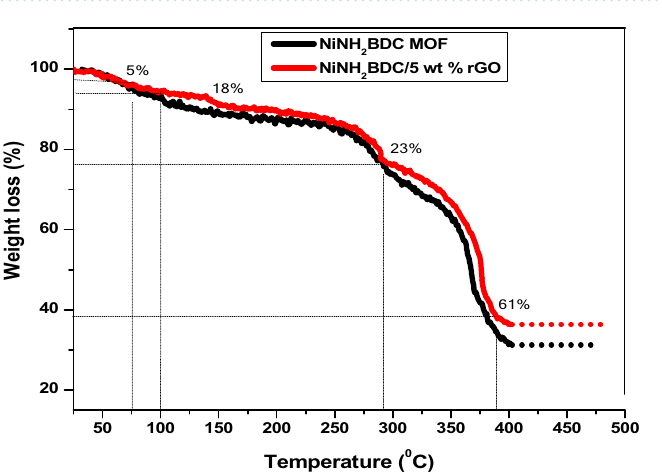
Figure 5. Raman spectra of ( a ) rGO ( b ) NiNH 2 BDC MOF/1, 2, 5 wt% reduced graphitic carbon hybrids.